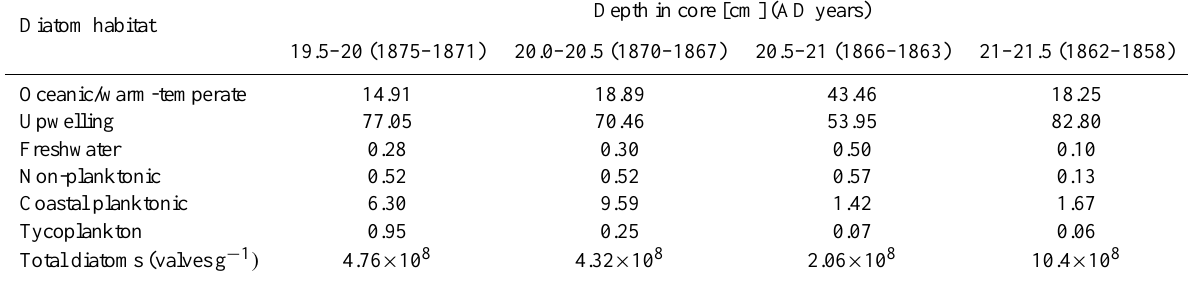
Table 2. Diatom valve counts in selected core depths around the spongy layer for core MUC-1B collected in Mejillones Bay (northern Chile). Species are grouped by habitat and/or distribution and are expressed as relative abundance (%) (S´anchez, 2009). Diatom